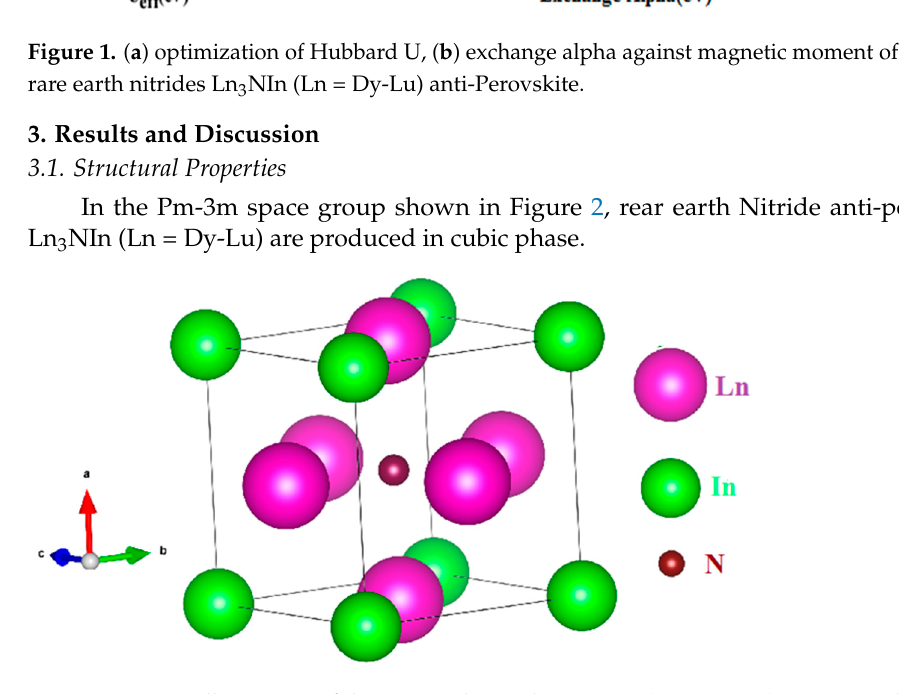
Figure 1. ( a ) optimization of Hubbard U, ( b ) exchange alpha against magnetic moment of Ln atom of rare earth nitrides Ln 3 NIn (Ln = Dy-Lu) anti-Perovskite.